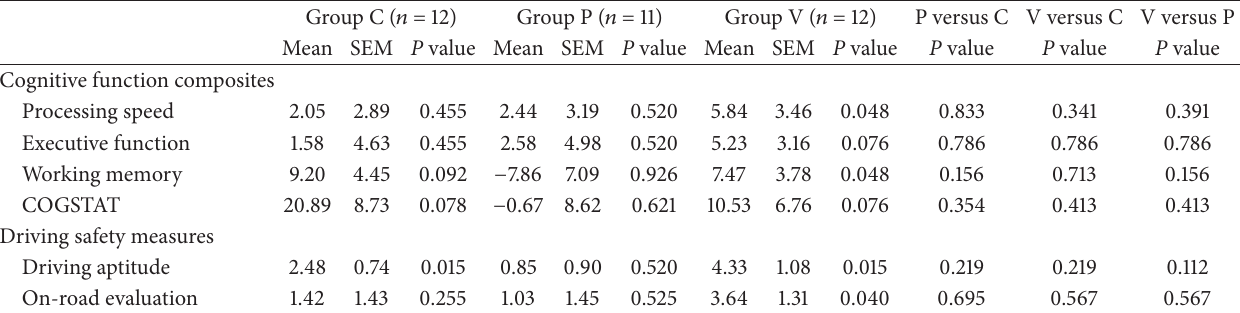
Table 4: Summary of the changes in the cognitive function composites and the driving safety measures within each training group and the statistical differences between the